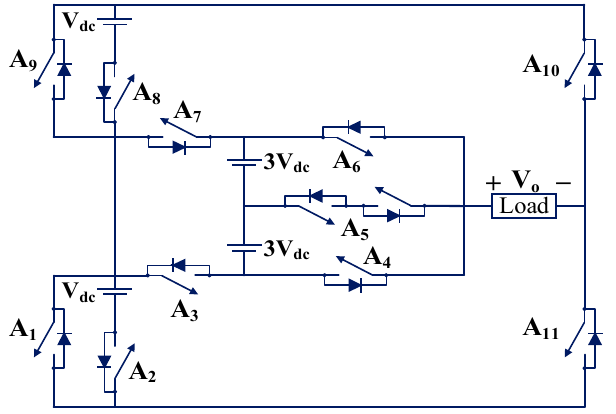
Figure 21. Single-phase fifteen-level FT MLI (TP22) [57].